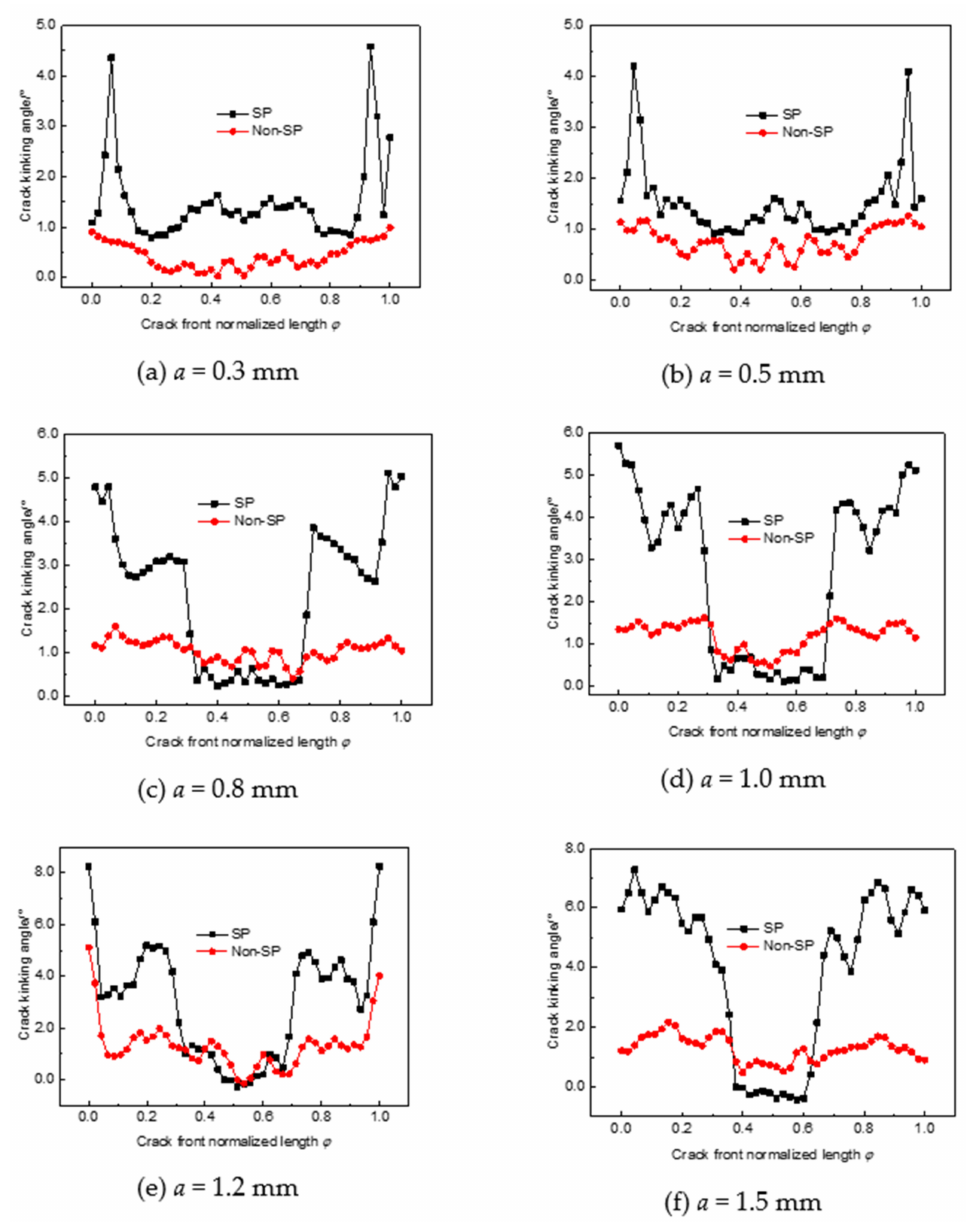
Figure 7. Crack kinking angle of peened and non-shot-peened parts. ( a ) a = 0.3 mm; ( b ) a = 0.5 mm; ( c ) a = 0.8 mm; ( d ) a = 1.0 mm; ( e ) a = 1.2 mm; ( f ) a = 1.5